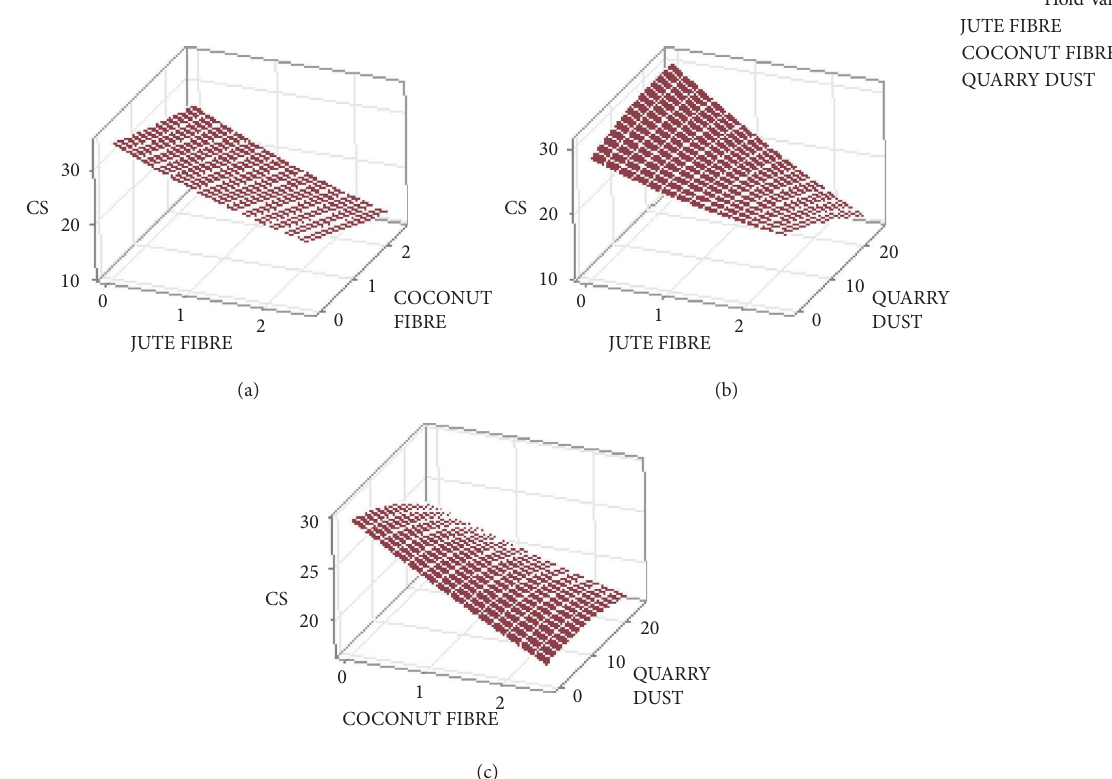
Figure 7: Surface plots for compressive strength as a function of (a) jute fbre and coconut fbre; (b) jute fbre and quarry dust; (c) coconut fbre and quarry